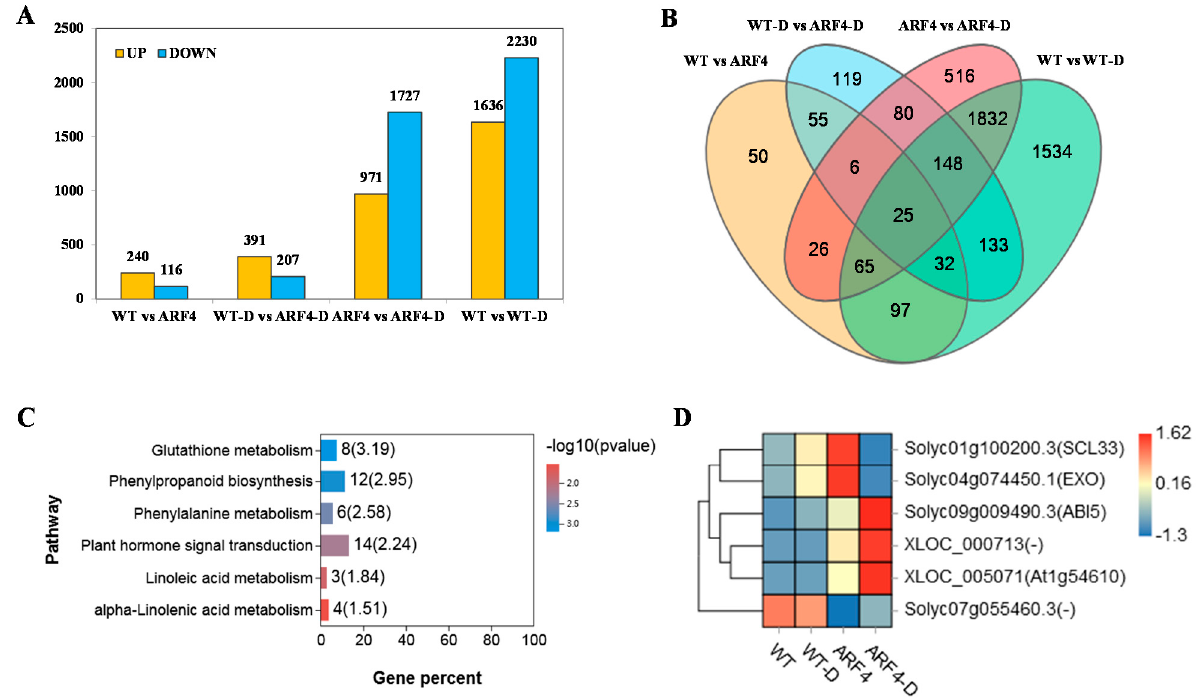
Figure 5. Analysis of differential gene expression between WT and arf4 mutant tomato plants. ( A ) Numbers of differentially expressed genes (DEGs) between WT and arf4 mutants under unlimited water supply and under water stress conditions, ( B ) overlap of these genes set. ( C ) Kyoto Encyclopedia of Genes and Genomes (KEGG) analysis of DEGs specifically expressed in arf4 plants under water stress and ( D ) heatmaps of six DEGs differently expressed between WT and arf4 plants under conditions of unlimited water supply and water stress. WT and arf4 under water stress are represented by WT-D and arf4-D (auxin response factor ARF4-D), respectively.